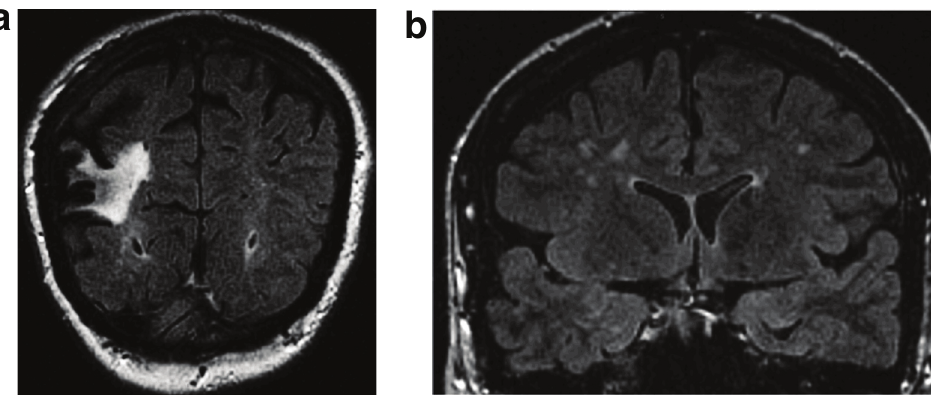
Figure 1a–b. Coronal FLAIR images demonstrate both large and small vessel disease. 1a Large hyperintense cortico-subcortical area consistent with a chronic stroke involving the right middle cerebral artery territory. 1b Focal bilateral white matter hyperintensities reflecting small vessel disease. Figure origin: Department of Radiology, Hospital Clinic